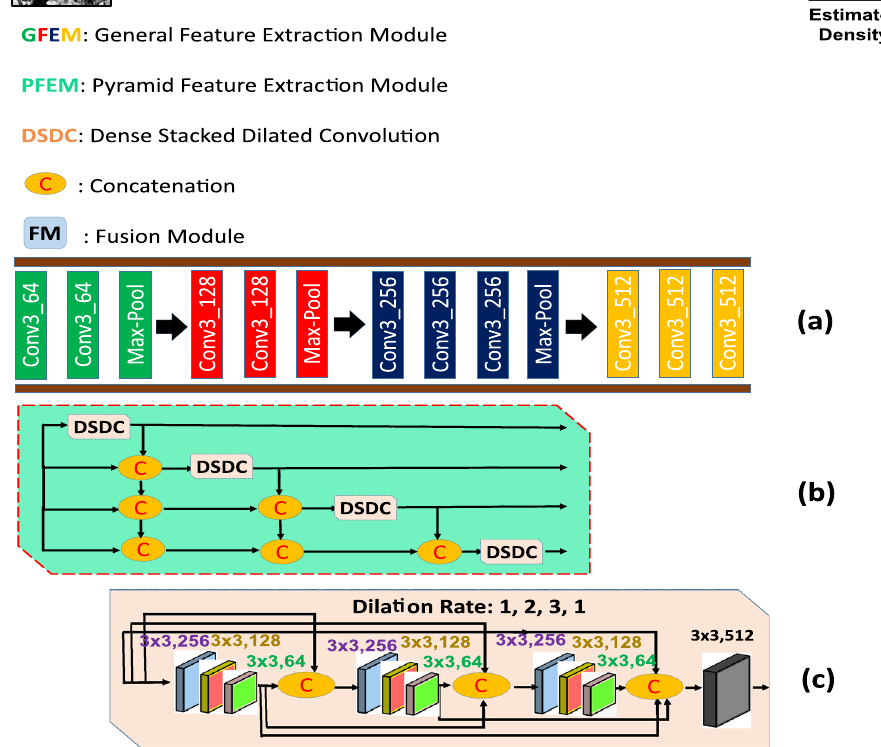
Figure 1. The overview of HDPF, A hierarchical dense dilated deep pyramid feature extraction CNN for single image crowd counting (top). The general feature extraction module (a) , the pyramid feature extraction module (PFEM) with four deep stacked dilated convolution (DSDC) blocks densely connected with each other (b) , while output is fused through fusion module (FM). The expansion of DSDC with multiple convolution layers densely connected with each other (c)